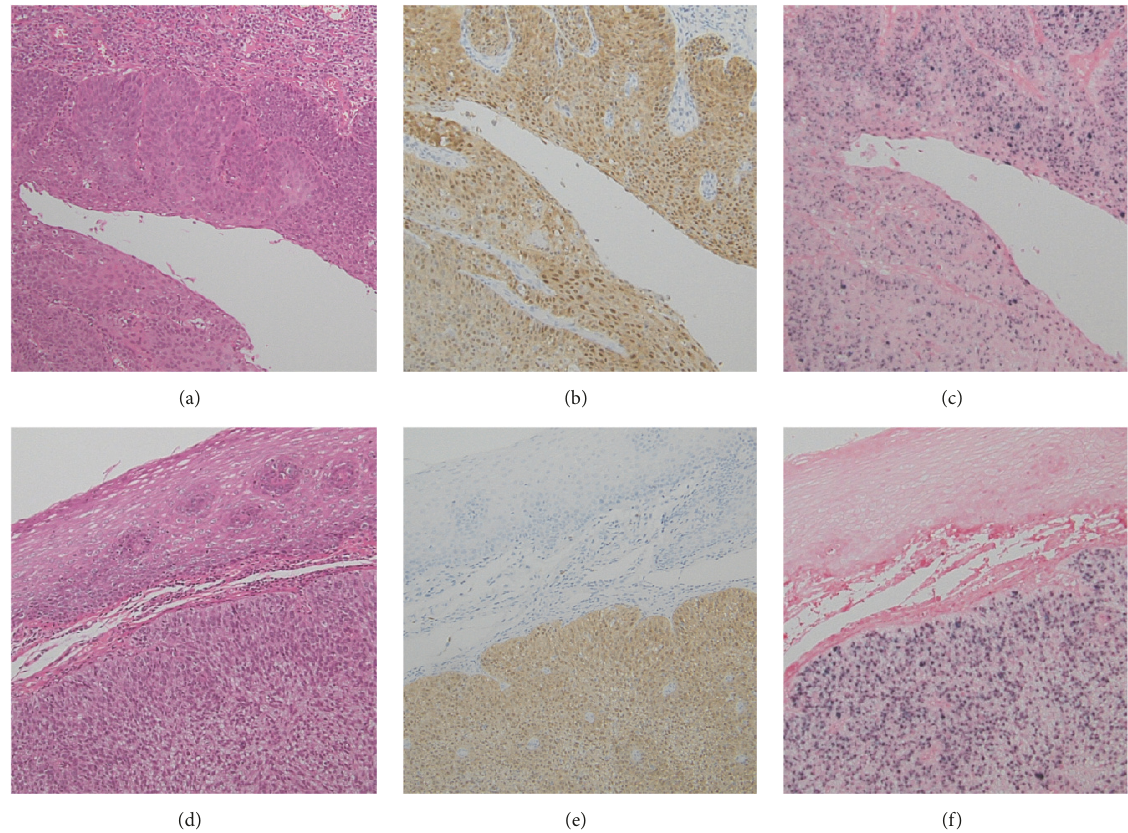
Figure 4: Histopathological results ((a), (b), and (c) right side; (d), (e), and (f) left side). Histopathological analysis of the biopsied tonsillar specimen revealed poorly differentiated SCC ((a) and (d)). Immunohistochemical staining for p16 was strongly positive in both lesions ((b) and (e)). ISH was positive for high-risk HPV ((c) and